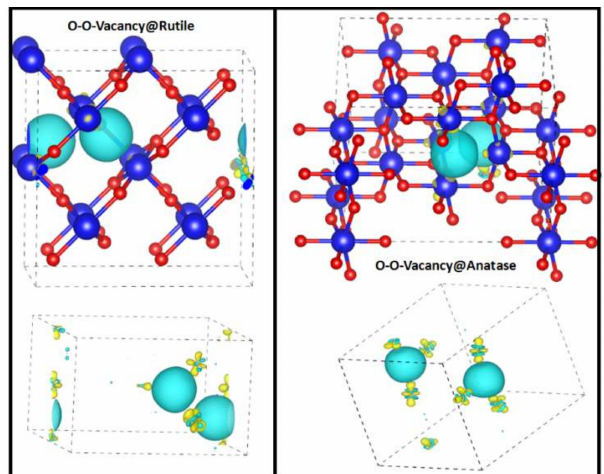
Figure 4. The di ff erence between charge densities of the double O-vacancy and pure bulk structures of rutile and anatase. The blue and yellow lobes represent the negative and positive levels of isosurfaces, respectively. The net charge transfers have also been represented. Red and blue spheres represent O and Ti atoms, respectively.